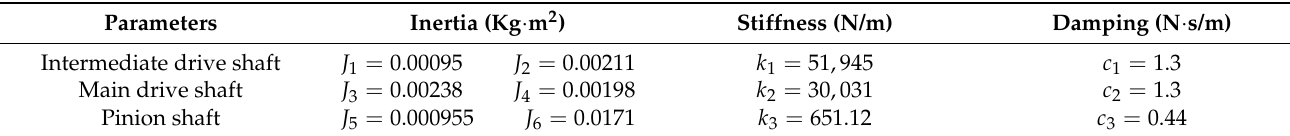
Table 1. Parameters of the drive shaft.